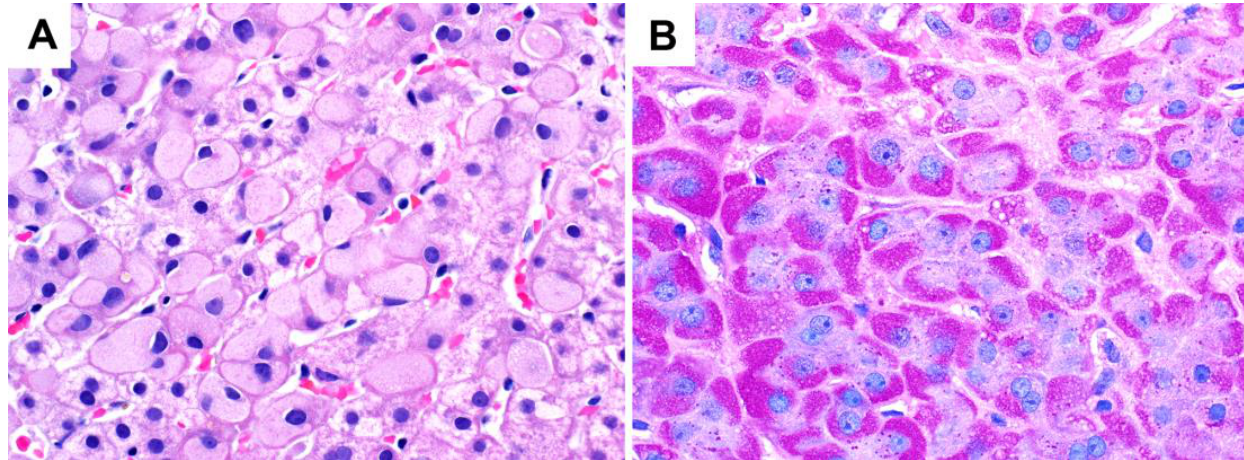
Figure 6. Drug-induced changes in the liver (original magnification 600×): ( A ) glycogen pseudoground glass changes in polypharmacy; ( B ) “two-tone” hepatocyte cytoplasmic appearance highlighted by PAS stain, possibly due to abnormal endoplasmic reticulum proliferation.